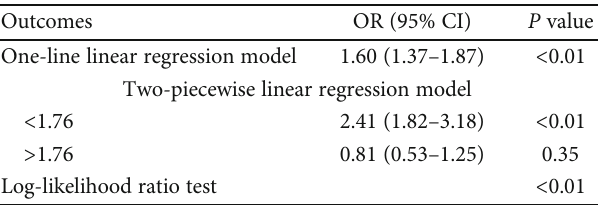
Table 3: Threshold e ff ect analysis of TG/HDL-C on the incidence of type 2 diabetes mellitus in the REACTION study.